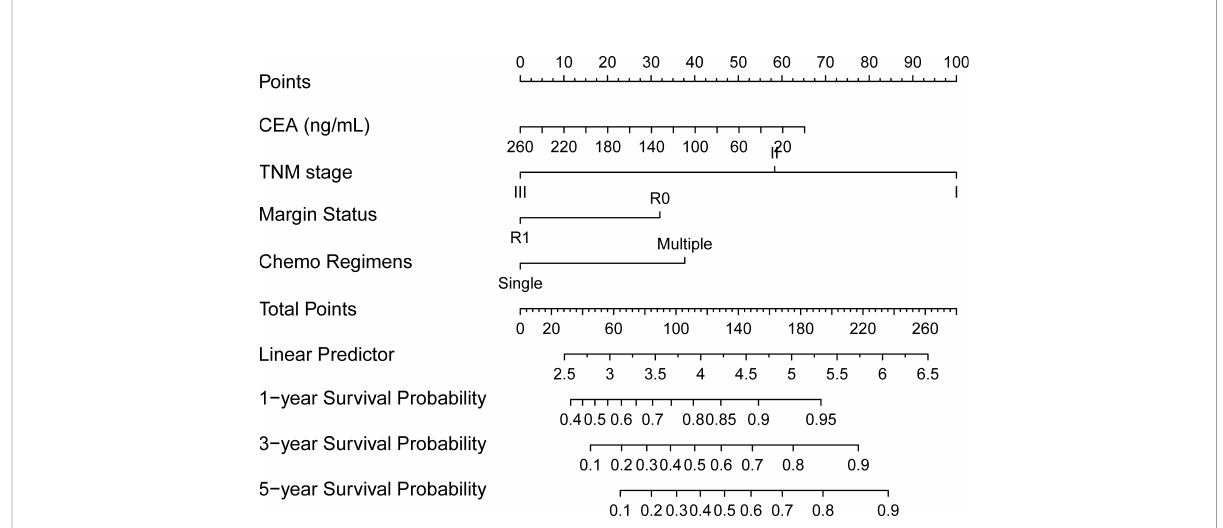
FIGURE 2 A nomogram for gastric cancer patients undergoing radical surgery and adjuvant chemotherapy. (To use the nomogram, for an individual patient, the value is loaded on each variable axis (the 2nd-5th lines), and a line is drawn upward to determine the number of points received for each variable value (the 1st line). The sum of these numbers is located on the total points axis (the 6th line), and a line is drawn downward to the survival axes (the 8th-10th line, separately) to determine the likelihood of the 1-year, 3-year, and 5-year survival